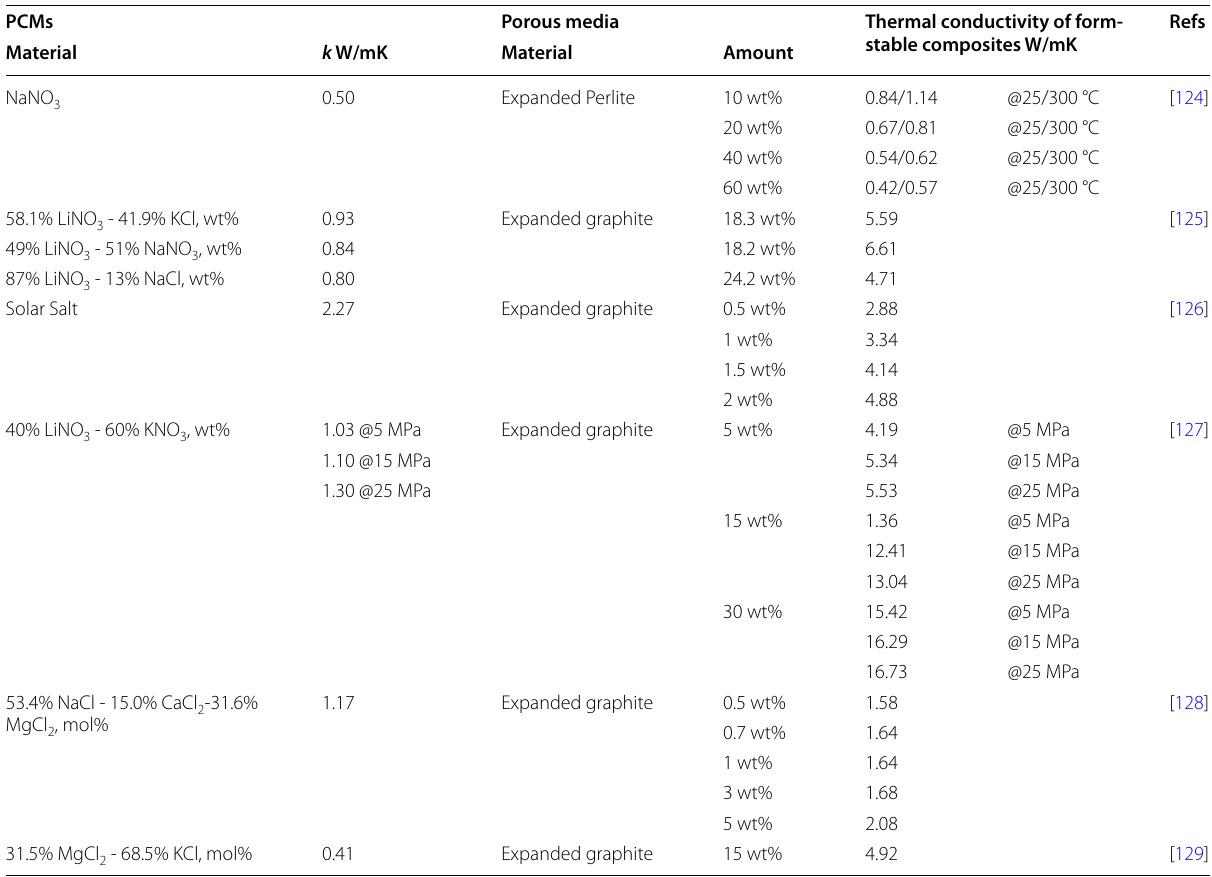
Table 8 Thermal conductivity of some composite PCMs embedded in porous media PCMs Porous media Thermal conductivity of form-